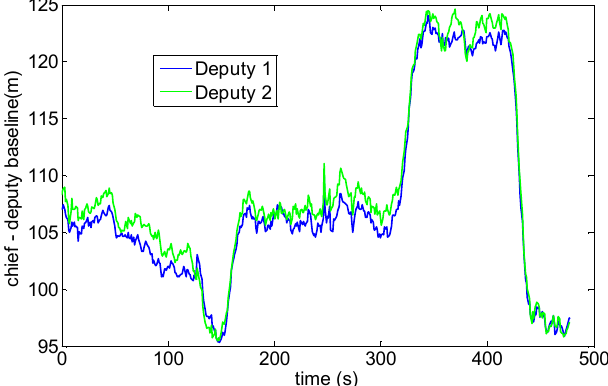
Figure 9. Formation geometry Test 1.